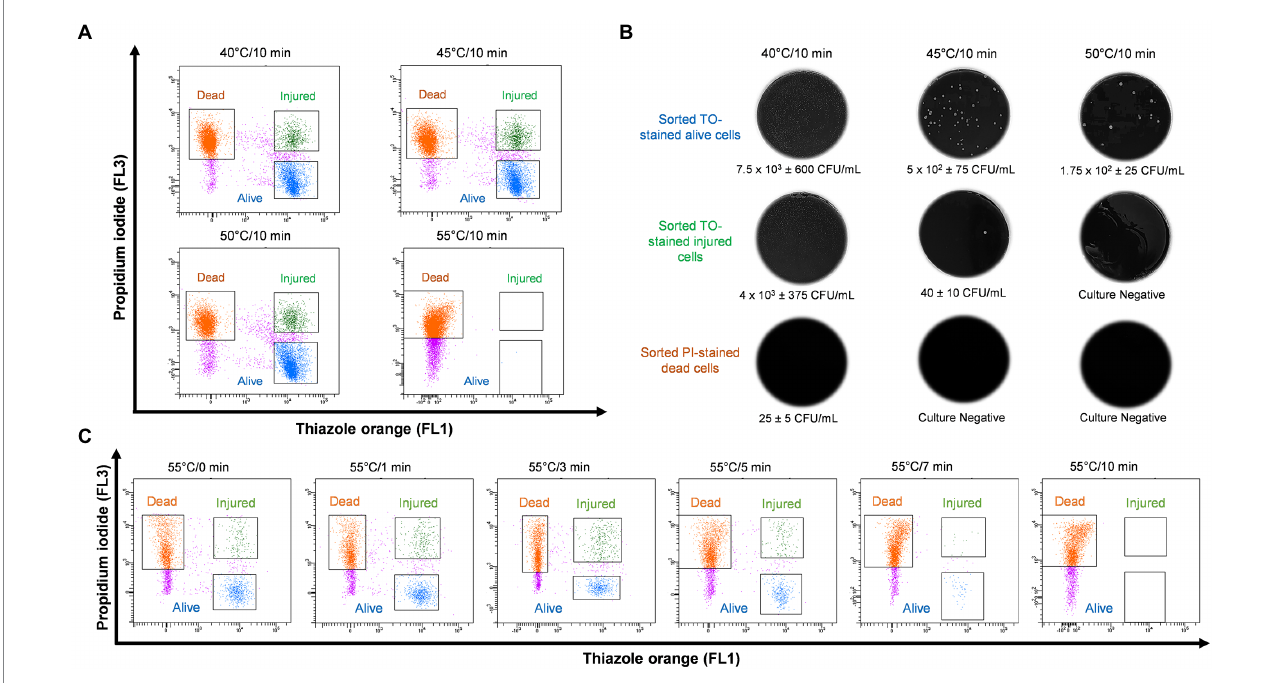
FIGURE 3 Legionella pneumophila thermal profile and culturability assay. (A) Bacterial cells were heat shocked at 40–55 ° C for 10 min and analyzed using flow cytometry. (B) Sorted cell fractions cultured on BCYE agar. Thermal shock at 50 ° C for 10 min transformed TO-stained injured cells into VBNC Legionella , as indicated by the lack of growth on the BCYE agar. (C) Pure culture of L. pneumophila subjected to 55 ° C thermal treatment in increments from 0 to 10 min. The population of VBNC L. pneumophila increased gradually with time 9% at 1 min, 20% at 3 min and then decreased to 5% at 5 min.